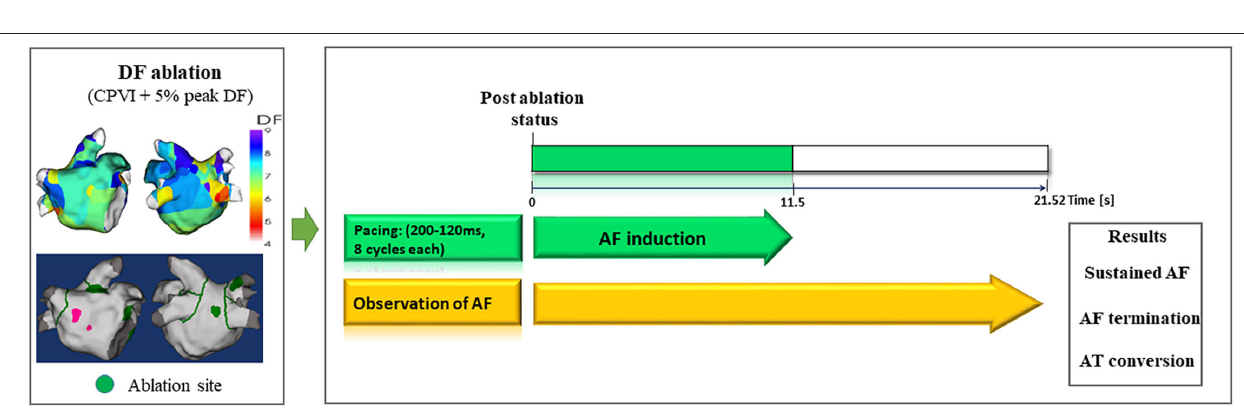
FIGURE 2 | Summary and example of how the Smax and dominant frequency were measured during the virtually induced atrial fibrillation. Smax, the maximal slope of action potential restitution curve; DF, dominant frequency.